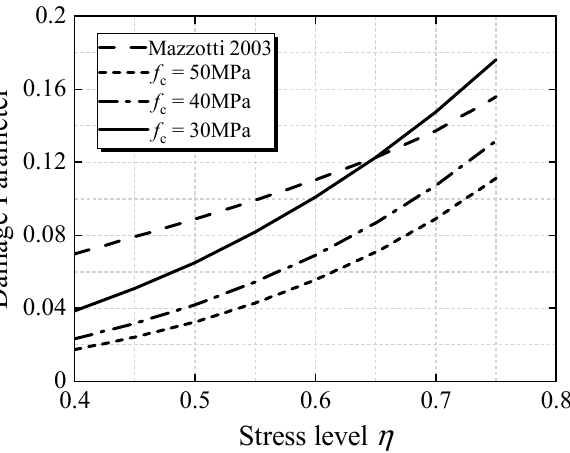
Figure 4. Variation curve of damage parameters with stress level, compared with Mazzotti [16]. The stress–strain curve of concrete under uniaxial compression is shown in Figure 5.